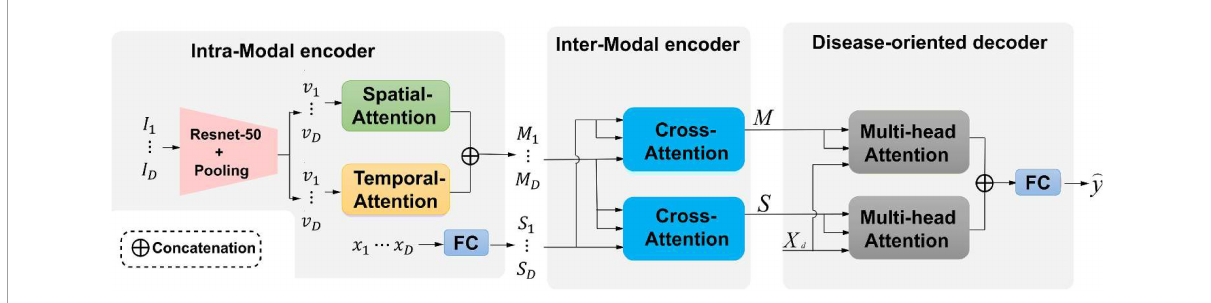
FIGURE1 An illustration of the proposed framework for the risk prediction of brain degeneration. Our framework has two attention encoders and one decoder. { I i ∈ R { H × W } (cid:12) (cid:12) i ∈ { 1 ,..., D }} is an MRI sequence I . { v i ∈ R { H × W } (cid:12) (cid:12) v ∈ { 1 ,..., D }} is an MRI features representation. { x i ∈ R { H × W } (cid:12) (cid:12) x ∈ { 1 ,..., D }} is the corespongding Electronic Health Records (EHR) data of MRI. S and M are the feature representations across spatial-attention and temporal-attention, respectively. X d represents the classification query. b y is the final prediction label according to the categories of